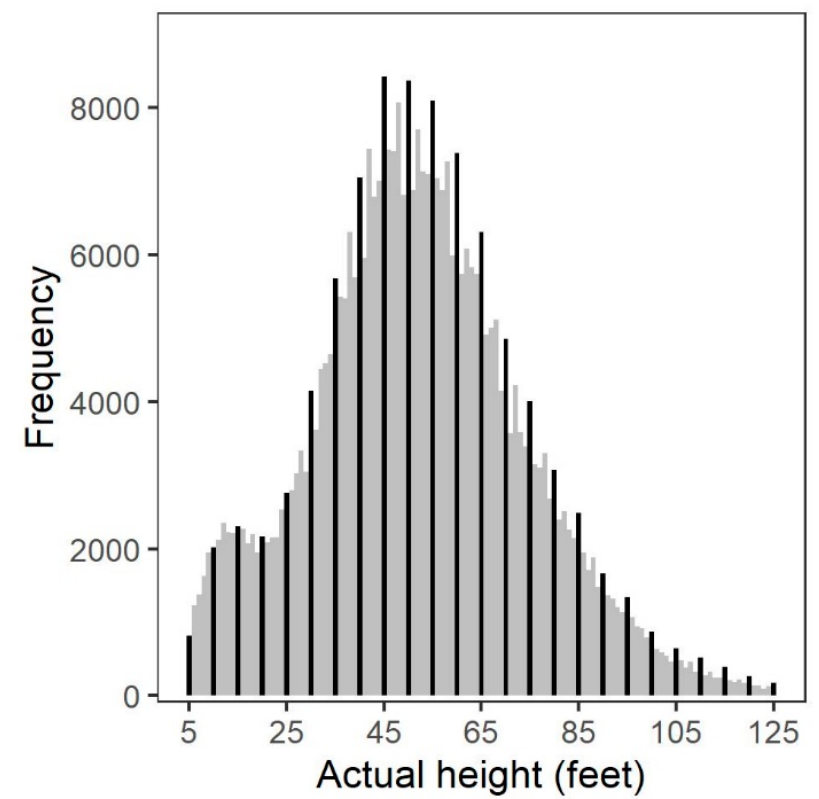
Figure 4. Actual height distribution for an exemplary subset of tree-sized stems. Darkest bars indicate values ending with the digit zero or five. Table 4. Estimated coefficients (and standard errors) for the model 𝑙𝑜𝑔𝑖𝑡(cid:4666)𝜋(cid:4667) = 𝛼 + 𝛽 𝑥 ⋯ + 𝛽 predicting the probability that actual height ends with the digit 0 or 5 by region. (cid:2873) (cid:2873)